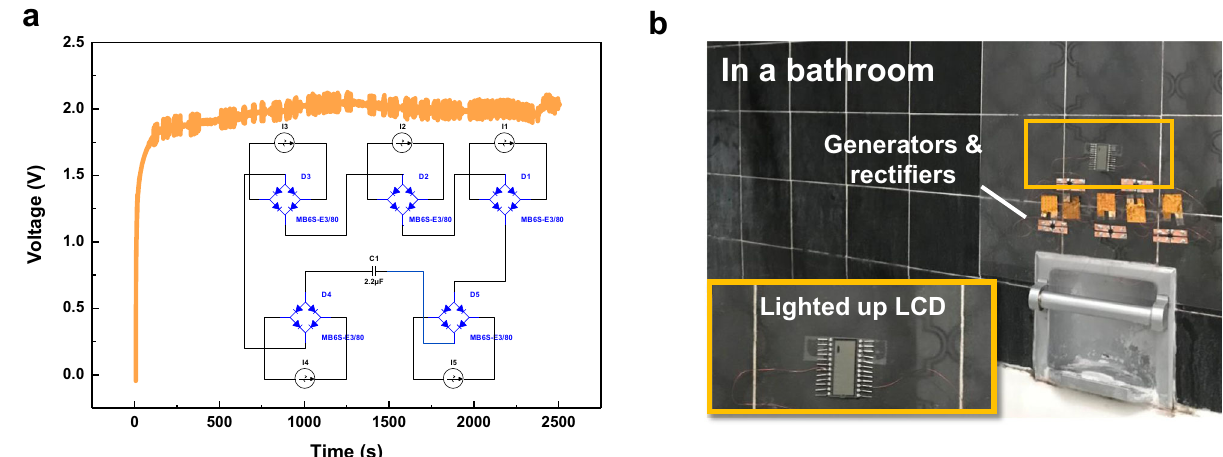
Fig. 6 Demonstrations of moisture-induced energy harvesters. a Recti fi ed output voltage vs. time by fi ve devices connected in series. Inset: the electrical circuit. b Lighting up a liquid crystal display in a bathroom with moisture from the shower. The inset shows the enlarged view of the